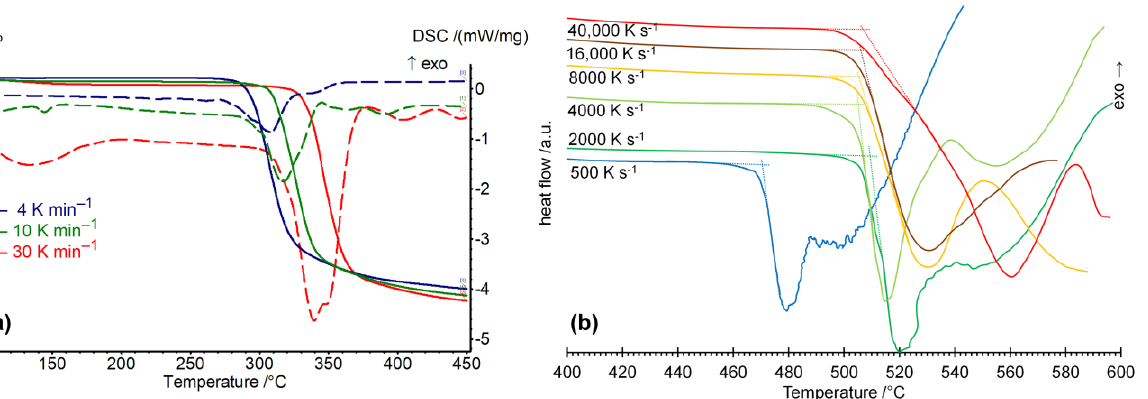
Figure 1. The influence of heating rates on the curves of thermal analysis of dry α -cyclodextrin: ( a ) simultaneous TG (solid lines) and DSC (dashed lines), ( b ) FSC experiment, where the cross-points of dotted lines indicate the onset points T o of the main endothermic effect of decomposition or fu- sion. Table 1. Onset temperatures ( T o ) of main endothermic peak for anhydrous natural cyclodextrins at different heating rates ( β ) *.